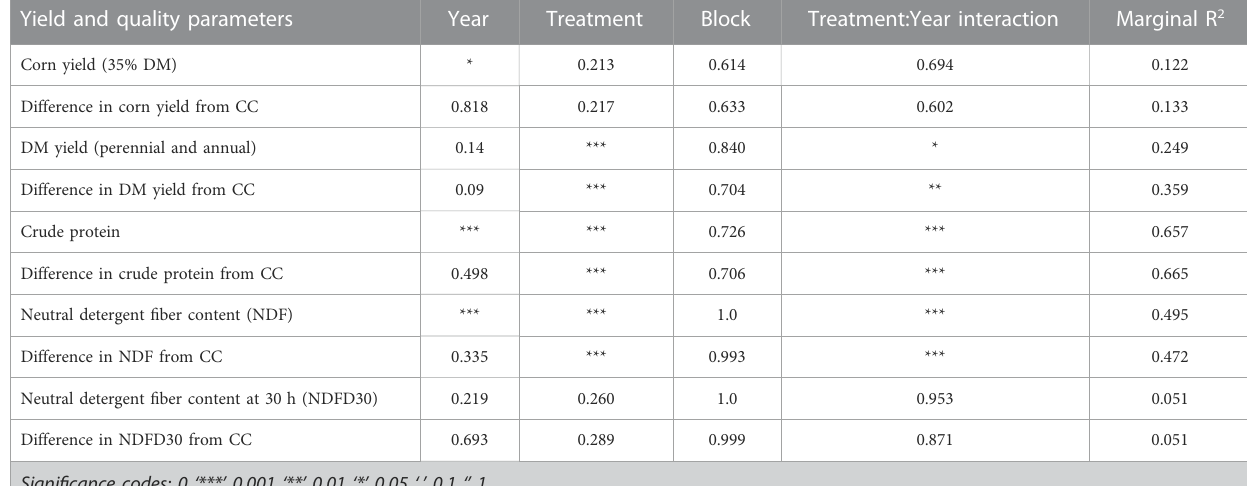
TABLE3Signi fi cant in fl uencesonyieldsandforage quality; ANOVA p -values andMarginalR2valuesofrepeated measures linear mixedmodelsofcorn yield (35% DM), dry matter yield for corn and forage, and forage quality, as well as the deviance in those metrics from continuous corn (CC). Yield and quality